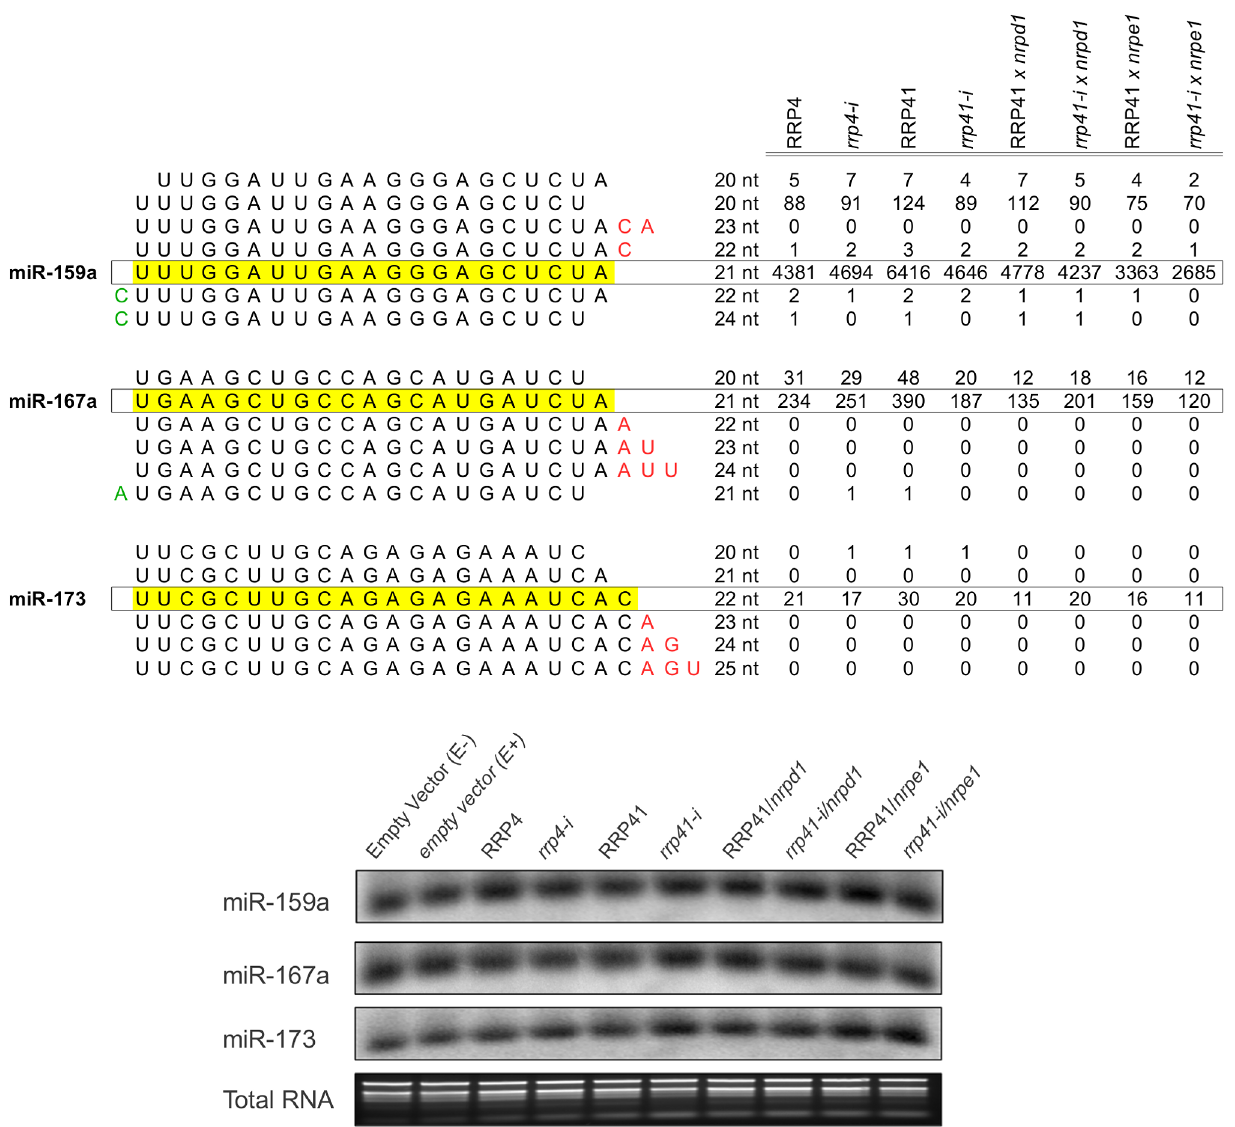
Figure 3. Expression of miRNAs in exosome mutants. miRNA families, miR-159a, miR-167a, miR-173 and variations in sequence length in each family. smRNAs mapped to matching mature miR-159, miR-167miR-173, and miR-167 sequences [94](miRBase release 18) were plotted versus the sum of their normalized reads per million (rpm) from smRNA libraries constructed from RRP4, rrp4-i , RRP41, rrp41-i , RRP41 /nrpd1, rrp41 iRNAi/nrpd1 , RRP4 iRNAi/nrpe1 and rrp41 iRNAi/nrpd1 mutants. Detection of miRNAs by Northern Blot analysis demonstrates that mature miRNA levels are not affected by exosome depletion, and confirms the results of bioinformatic analysis. Total RNA stained with ethidium bromide was used as a loading control.